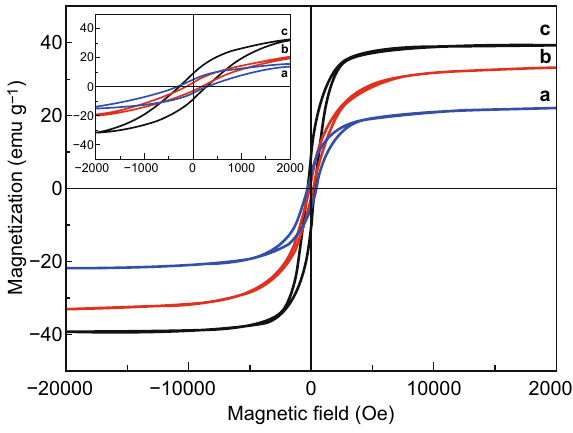
Fig. 7 Magnetic hysteresis loops for a Fe–Co/NC/rGO, b Co/NC, and c Fe–Co/NC